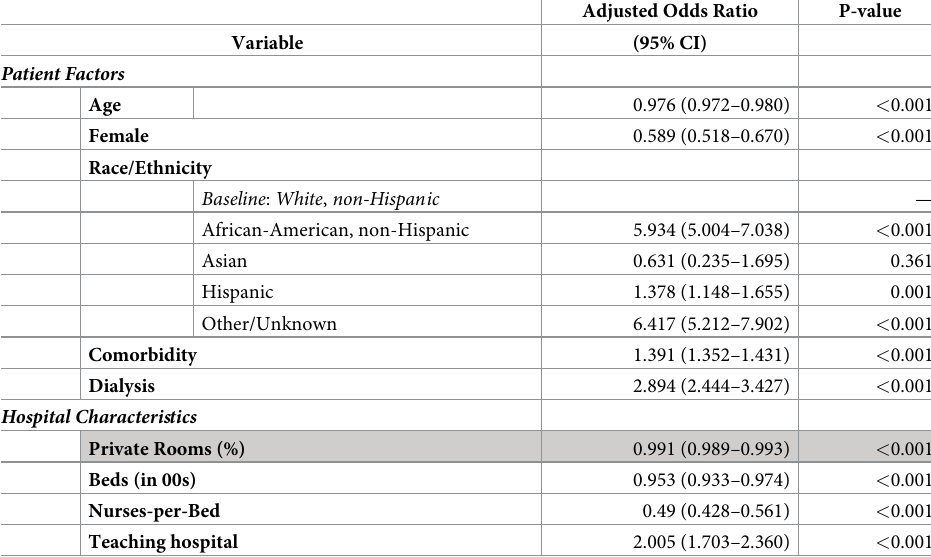
Table 4. Impact of hospital private room (%) on CLABSI